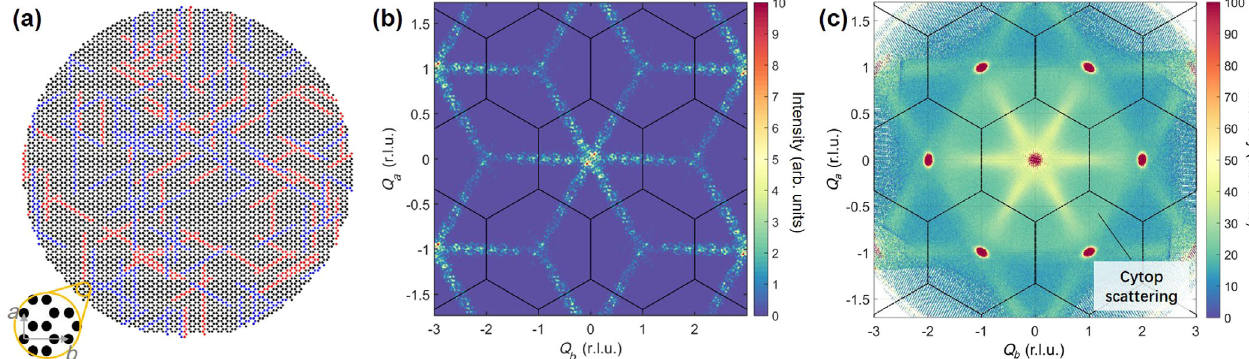
FIG. 6. (a) A random placement of ferromagnetic zigzag chain segments on a honeycomb lattice. Blue, red, and black circles indicate spin-up, spin-down, and spinless sites, respectively, which contribute positive, negative, and zero neutron-scattering amplitudes in the simulation. (b) Fourier component squared of the scattering amplitudes in the field of view in (a), computed on a fine 2D momentum grid. (c) Neutron diffraction intensities at 10 K, similar to those in Fig. 5(c) but acquired with a higher incident energy (Table S2 in Ref. [58]). Data are Q ⊥ integrated and are C 6 symmetrized for better comparison with (b). Black hexagons indicate 2D Brillouin zones. Sharp diffraction spots are nuclear Bragg peaks. Halolike diffuse intensities in the first and part of the second zones are T -independent scattering from the sample holder and glue